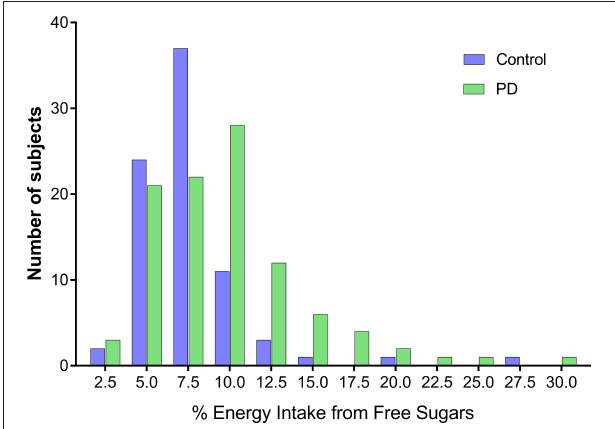
FIGURE 2 | Comparison of relative energy intake from free sugars between Parkinson’s disease patients and healthy controls. Parkinson’s disease patients consumed more free sugars as a proportion of energy intake compared to healthy controls.